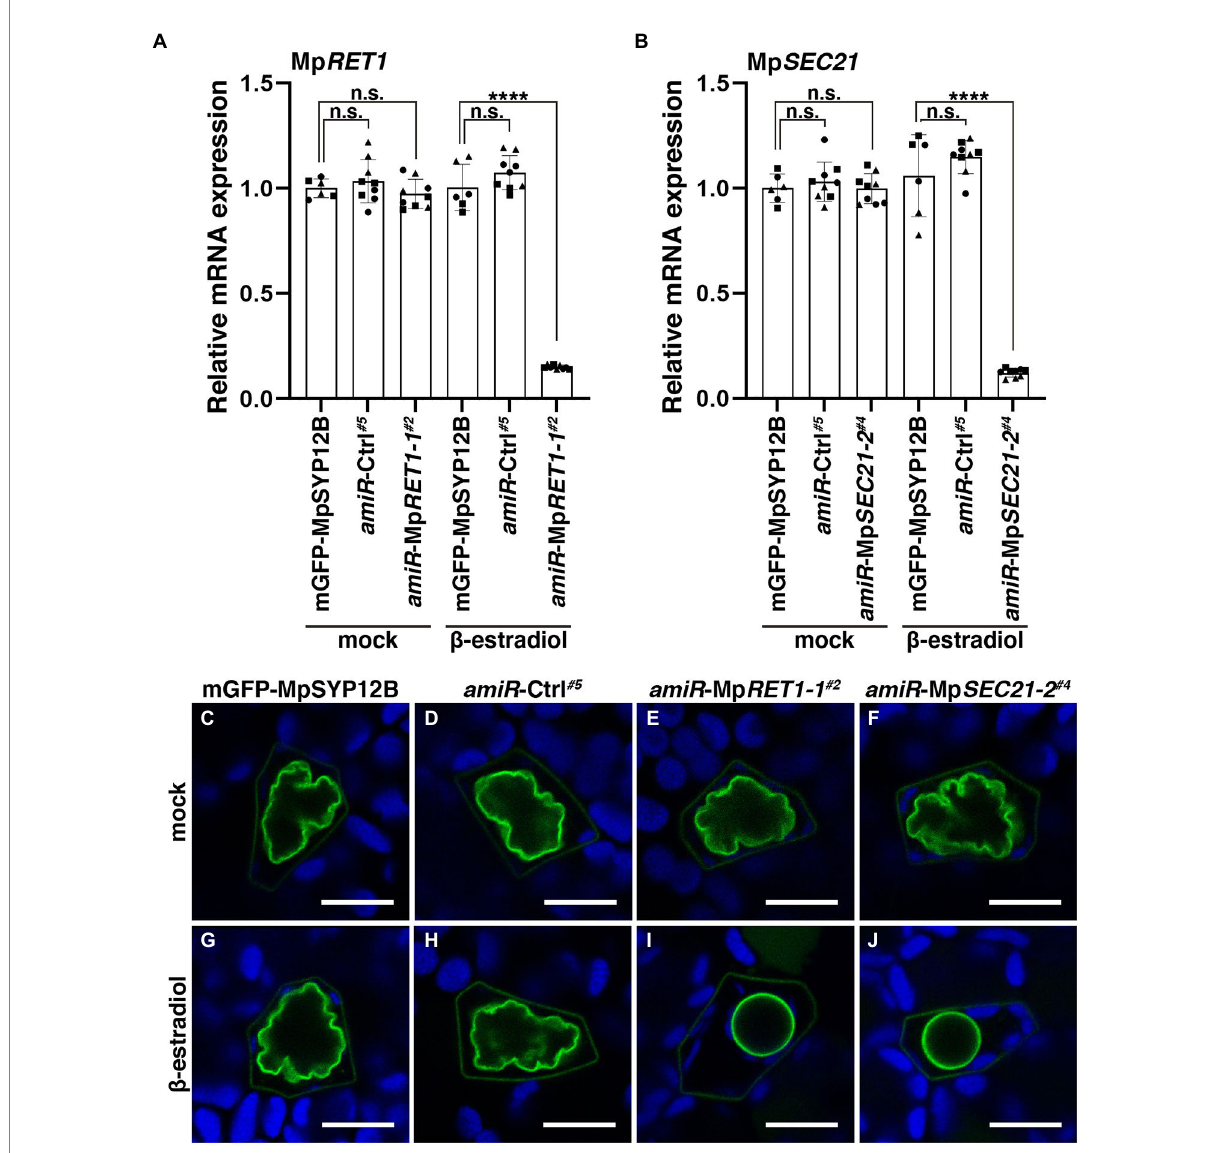
FIGURE 2 Defects in COPI function result in abnormally shaped oil bodies. (A,B) Relative Mp RET1 (A) and MpSEC21 (B) mRNA expression levels in transgenic M . polymorpha plants with indicated transgenes measured by qRT-PCR. Mp APT was used as an internal reference. Data are presented as the means ± s.d. Significant differences between mGFP-MpSYP12B and each genotype were statistically analyzed by a two-tailed Welch’s t -test. n.s.: not significant; **** p < 0.001. Three biological replicates were prepared, and experiments were performed two or three times for each gene. Each biological replicate is indicated by a circle (replicate 1), triangle (replicate 2), or square (replicate 3). (C–J) Single confocal images of M . polymorpha thallus oil body cells in mGFP-MpSYP12B (C,G) , amiR -Ctrl #5 (D,H) , amiR -Mp RET1-1 #2 (E,I) , and amiR -Mp SEC21-2 #4 (F,J) plants. Thalli were observed after 48 h of incubation with DMSO (0.1% v/v) (C–F) or 20 μ M β -estradiol (G–J) . Green and blue pseudo-colors indicate the fluorescence from mGFP and chlorophyll, respectively. Bars = 10 μ m. Representative images are shown among replicates. The Source data lists the number of observed